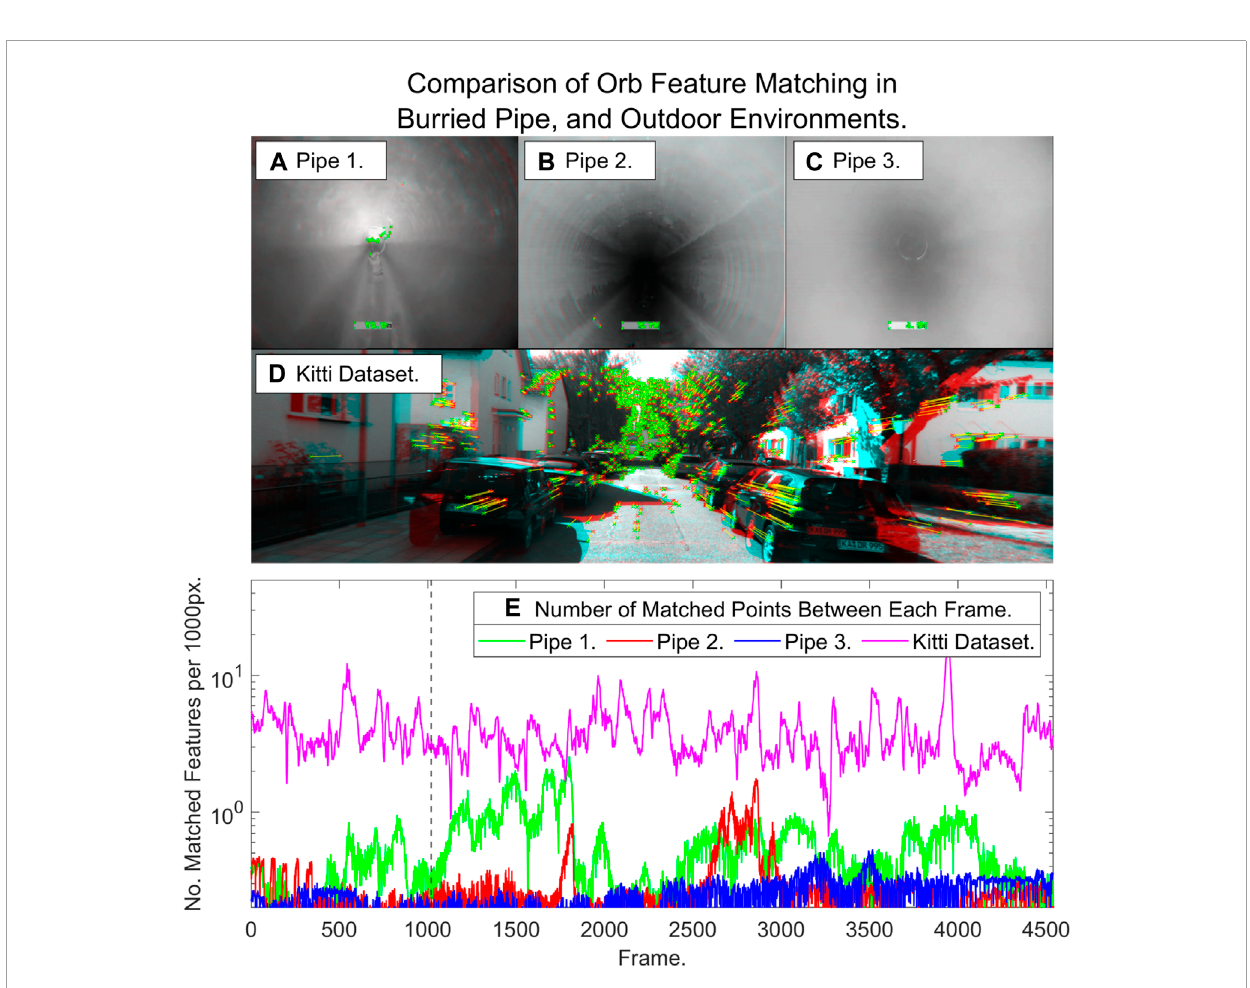
FIGURE 6 ORB feature extraction and matching in (A–C) sewer pipes versus (D) and outdoor scene from the KITTI dataset (matched points are shown in red and green pairs connected by yellow lines). (E) Quantification of feature matching normalised by 1000 pixels (note the logarithmic scale).